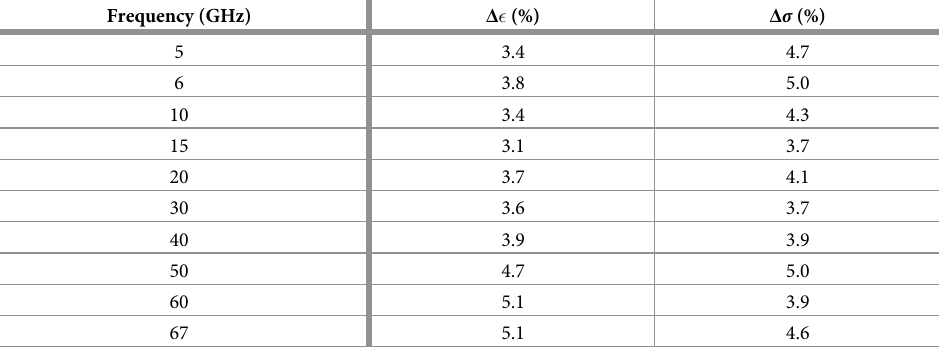
Table 1. Expanded uncertainties (k = 2) in the measurements of dielectric parameters made with the DAK-TL- 1.2E